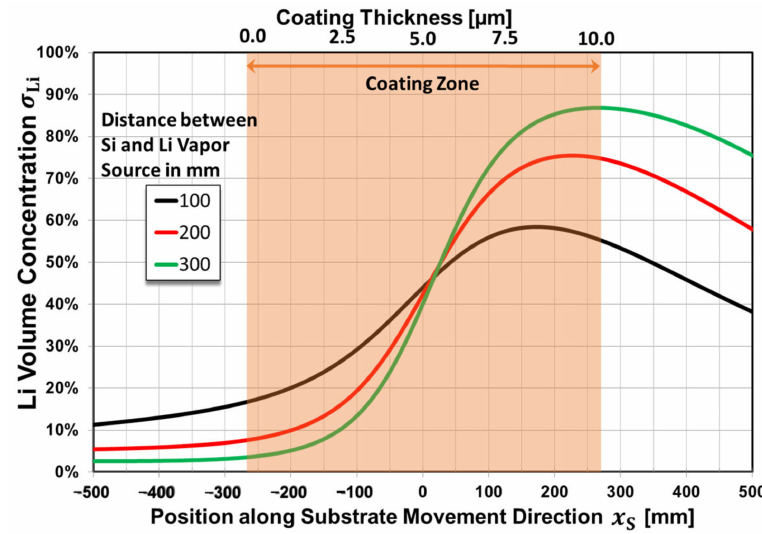
Figure 10. Calculated Li content in terms of substrate position for three distances of vapor sources during static deposition (cf. to fits of Figure 9). For a dynamic deposition of a layer 10 µ m in thickness within the coating zone, the curves correspond to the depth vs. concentration profiles in the layer-growth direction (upper abscissa).